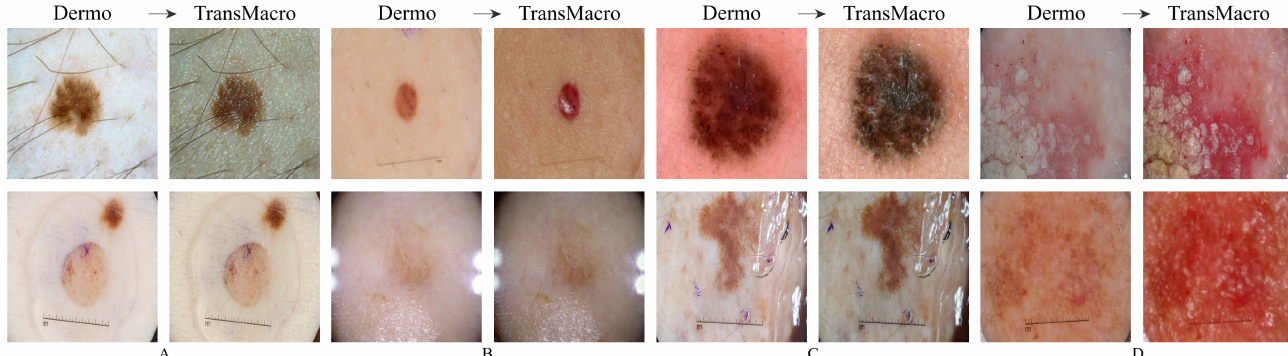
Figure 4. Examples of successful ( top row ) and failure cases ( bottom row ) of translation from the dermoscopic domain to the macroscopic domain in ISIC test subset. The letters A, B, C and D represent pairs of Dermo →